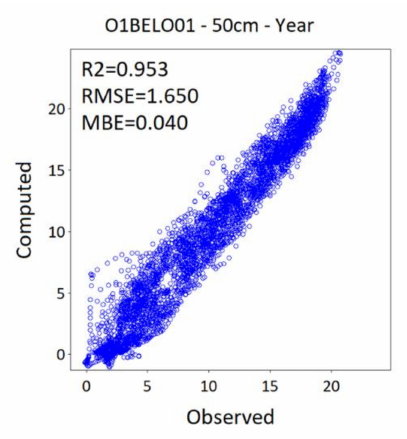
Figure A10. Validation at site O1BELO01 for 50 cm soil depth.